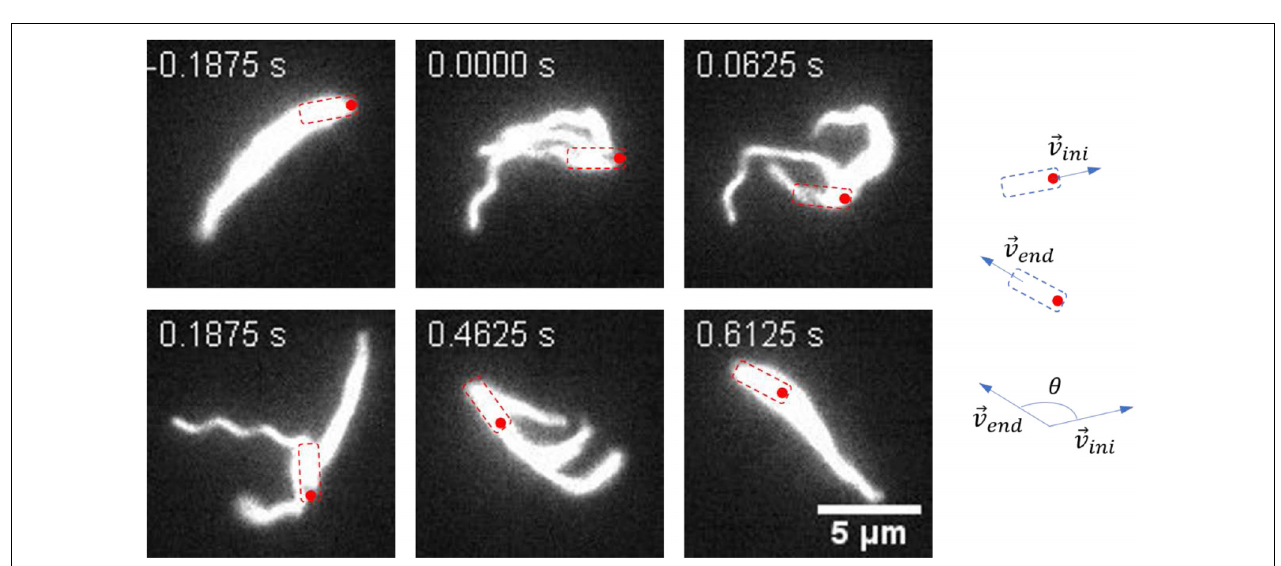
FIGURE 3 | Images sequences taken from Supplementary Movie S5 . The time stamp of each movie frame was shown. In this case, the filaments rolled from one end of the cell body to the other end and re-bundled. This process was usually accompanied with a large angle change of the moving direction. The cell body is indicated by a dashed box, and the red circle marks the position of the initial head. The large change in angle is schematically shown on the right.